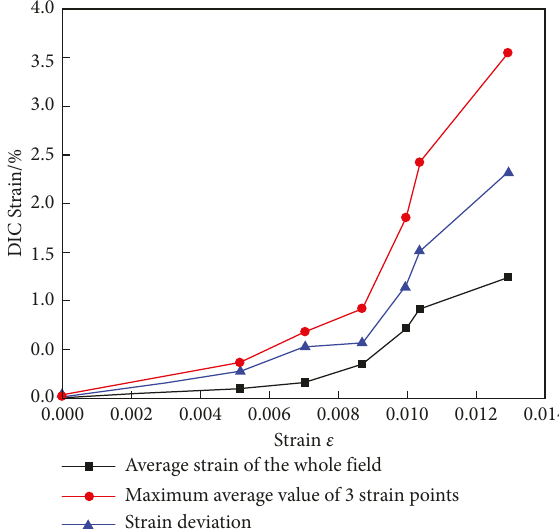
Figure 15: Test and fitted stress-strain curve of S-3-AB.